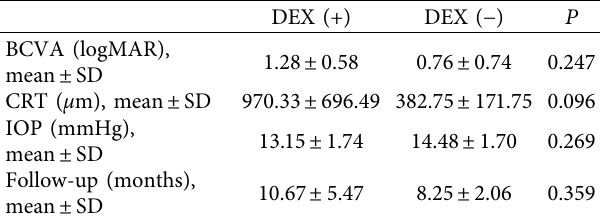
Table 1: Baseline clinical characteristics between two groups.